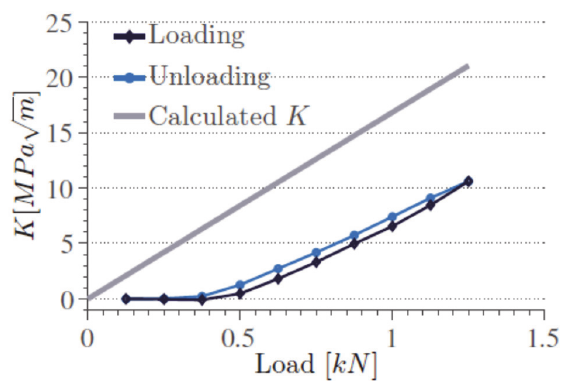
Figure 2: Variation of measured and calculated stress intensity factor with load, for a typical DIC experiment [5] In Fig.2., the residual K is apparent as an (almost constant) offset between the theoretical and experimental lines, once the crack is